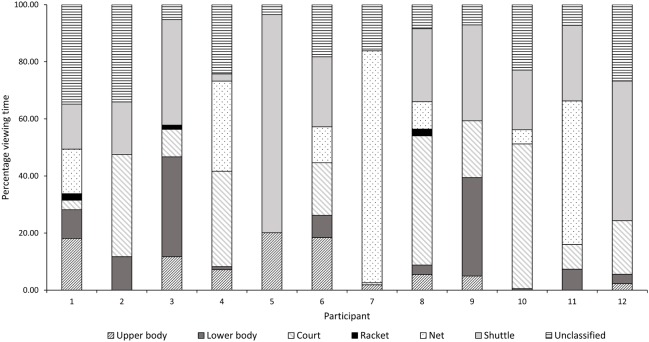
Mean and standard deviation of time spent viewing each AOI by individual participants (skilled) across conditions as a percentage of total viewing time.